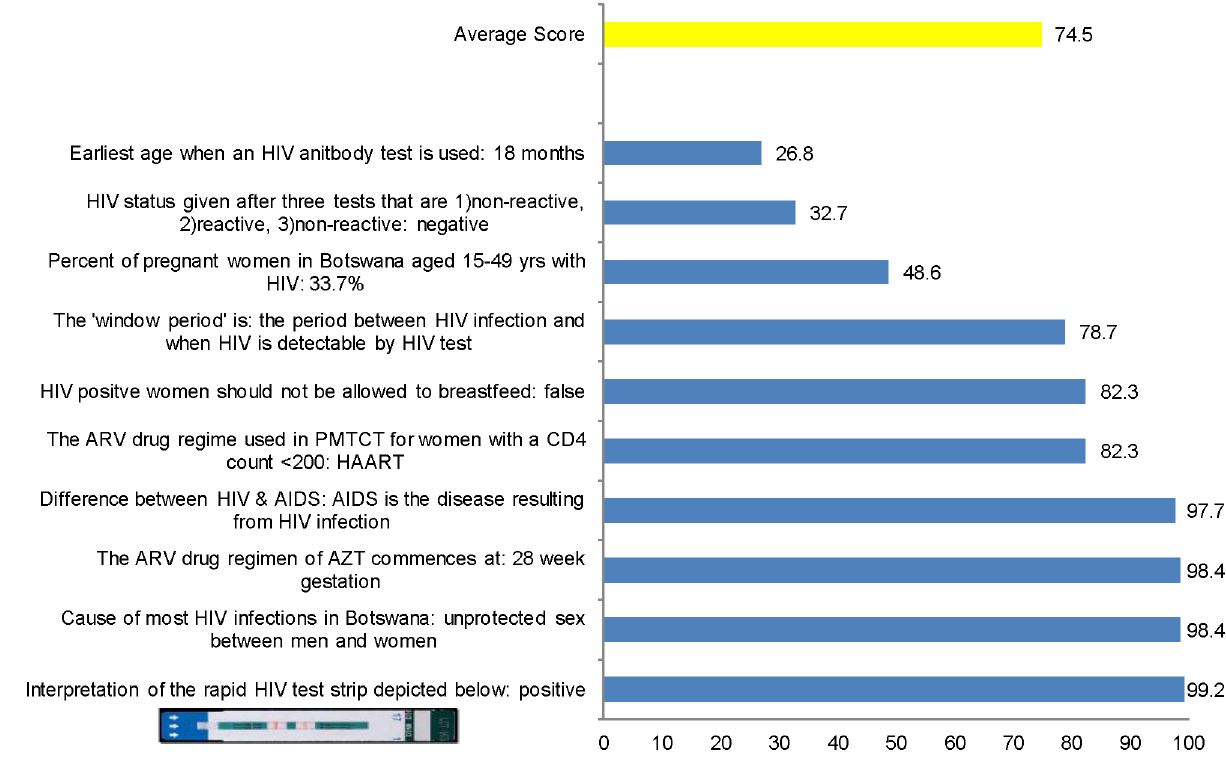
Figure 1. Percent score (correct responses) on 10-item knowledge test from the national survey (n=385 lay counselors).